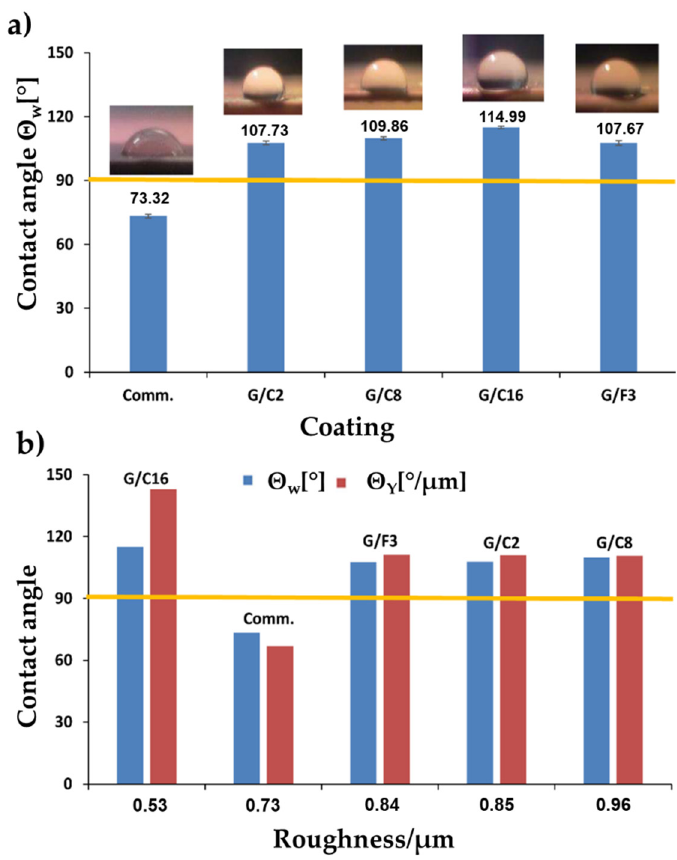
Figure 8. Histogram of the contact angle θ W of coatings with photos of the representative drops ( a ); comparison of contact angles θ W and θ Y vs roughness of coatings ( b ).